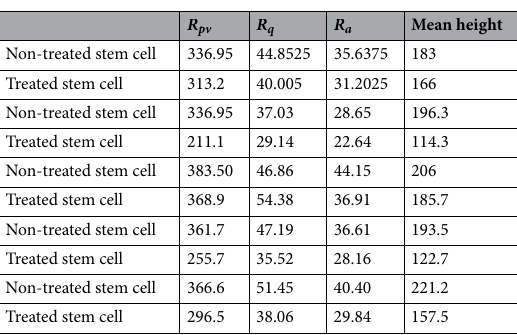
R pv R q R a Mean height 336.95 44.8525 35.6375